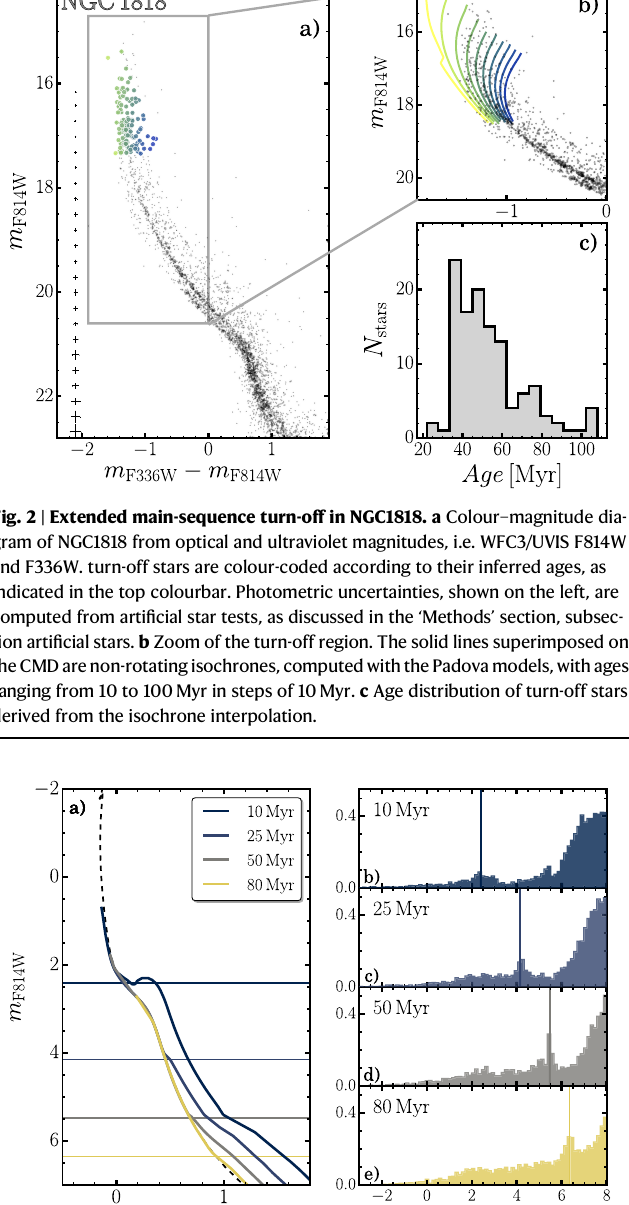
uncertainties,inferred with bootstrapprocedure, for observations and simulations, respectively, determined as the 68th percentile of each bin distribution. The red line in Fig. 4b represents the LF derived from the age distribution of turn-off stars, indicated in Fig. 4c with the same colour. The top-left inset in Fig. 4c shows the result of the best- fi t Gaussian. The analysis indicates a fast star formation for NGC1818 with a duration of <8Myr, which corresponds to four times the dispersion of the best- fi t Gaussianfunction, σ . On the other hand, considering the full width at half maximum (FWHM), more commonly used in the lit- erature, would further reduce starburst duration, to 4.7Myr. In con- trast, the age distribution inferred from the eMSTO (shown with a red solid line in Fig. 4c) would provide a smooth LF, which poorly matches the observed ones (Fig. 4b).